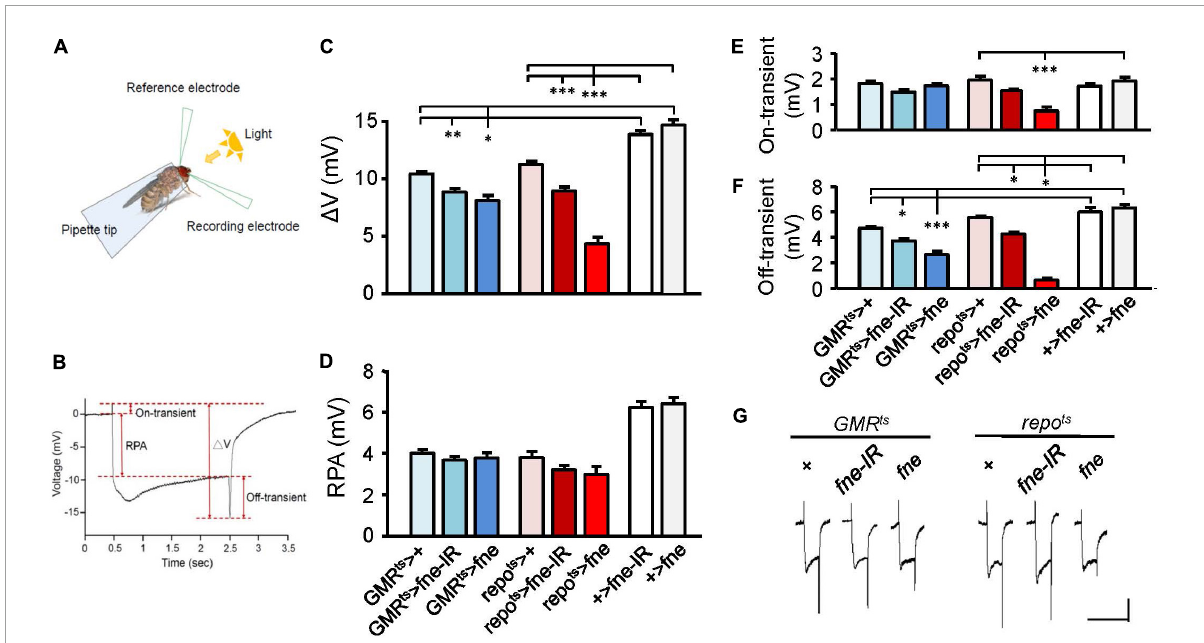
FIGURE1 fne is involved in the light-induced synaptic transmission in neurons and glia. (A) A schematic diagram of ERG recording. (B) The components of a representative ERG signal contain the (cid:49) V (the difference between on- and off-transient spikes), receptor potential amplitude (RPA), and on-transient (highest peak from baseline) and off-transient (lowest peak from baseline) spikes. Quantification of (C) (cid:49) V, (D) RPA, (E) on-transient, and (F) off-transient spikes. (G) The ERG trace of each genotype. Calibration: 2 mV, 5 s. Error bars represent SEM. n = 10 for each